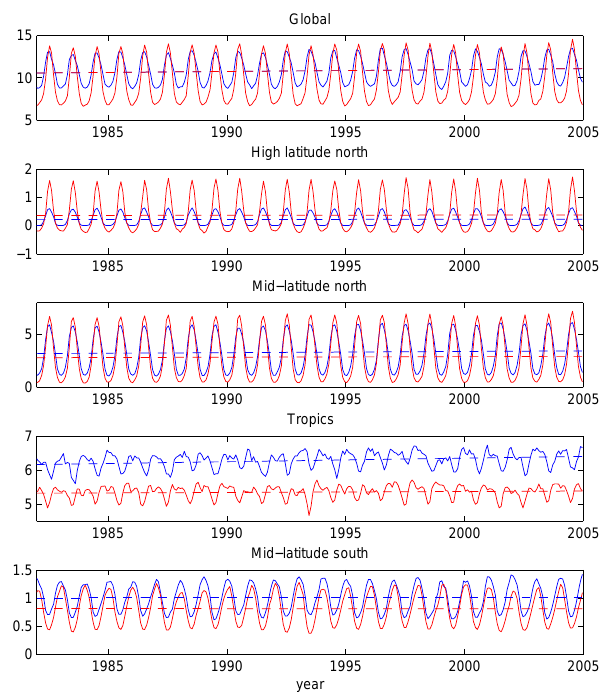
Fig. 20. Time series of monthly gross primary production (GPP) values simulated by NorESM (blue lines) as compared to the FLUXNET-MTE estimations (red lines). Shown are global value, high latitudes ( > 60 ◦ N), mid-latitude north (between 60 ◦ N and 20 ◦ N), tropics (between 20 ◦ N and 20 ◦ S), and mid-latitude south (between 20 ◦ S and 60 ◦ S). The dashed lines represent the linear trend of the time series. Units are in (PgCmonth − 1